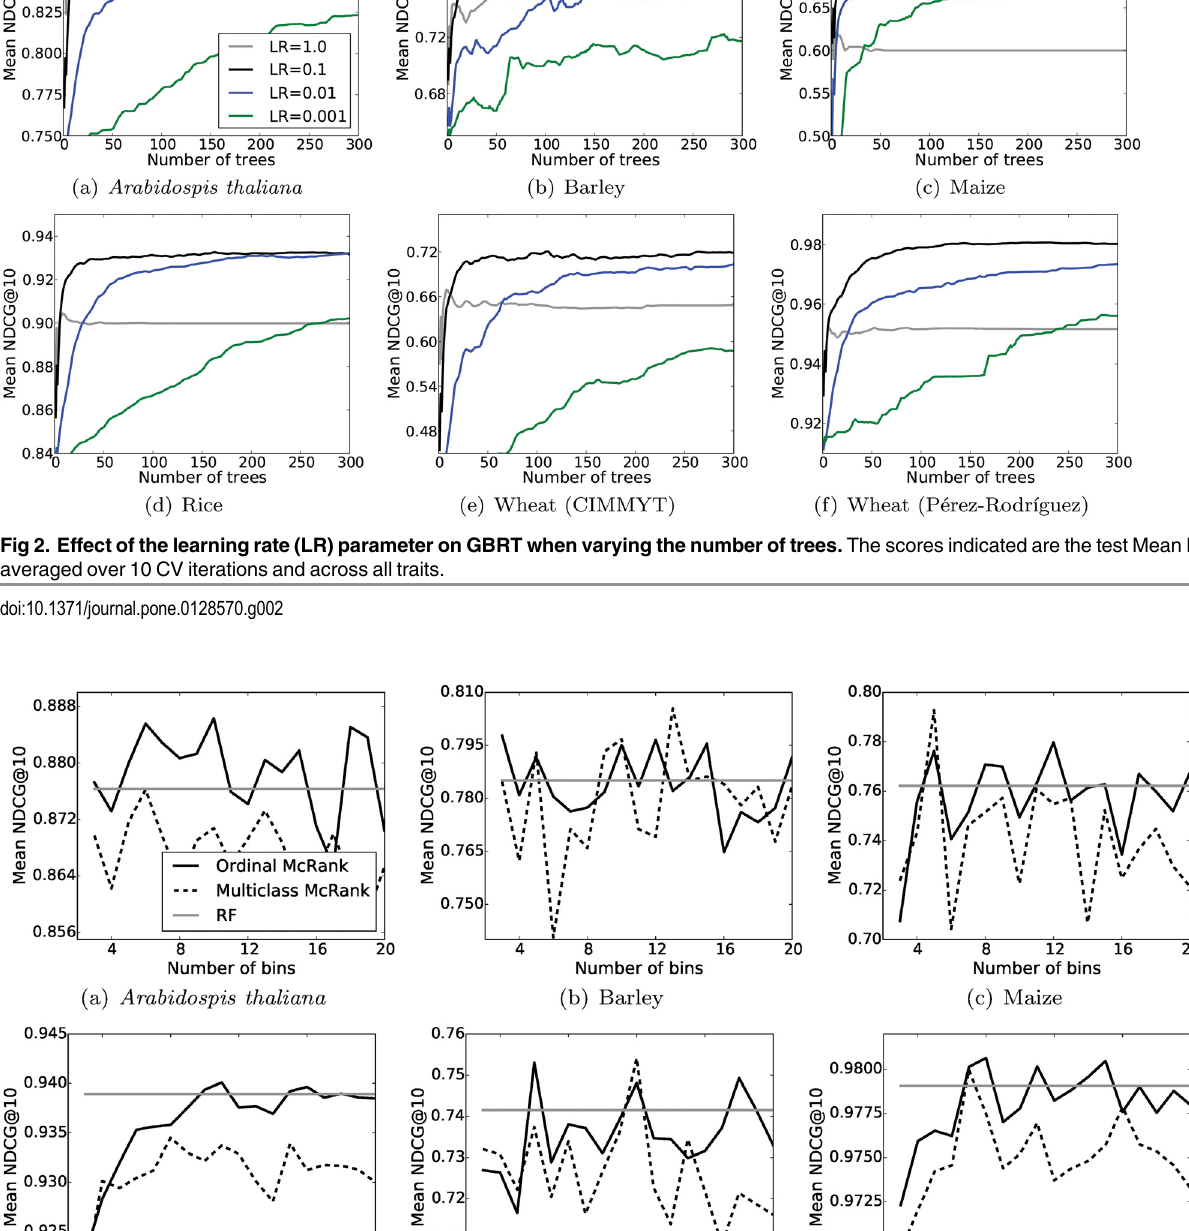
PLOS ONE | DOI:10.1371/journal.pone.0128570 June 12, 2015 18 /